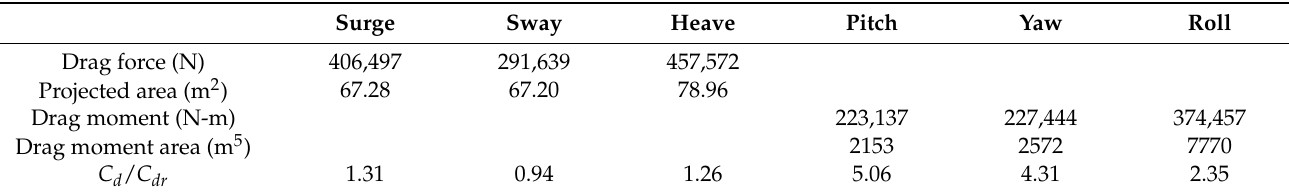
Figure 9. External moment received by the duct under the rotational motion of six degrees of freedom (6DoF). ( a ) Roll; ( b ) Pitch; ( c ) Yaw. ○ , simulation values; ― , Equation (13). Table 1. C d for the six degrees of freedom